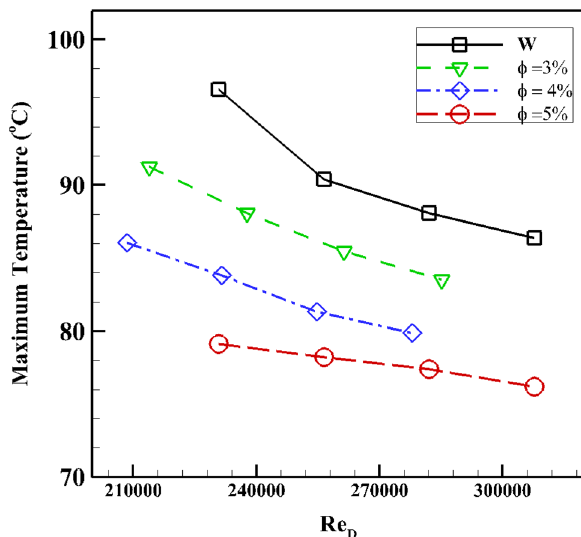
Fig. 29 Convective heat transfer ration at constant concentrations vs